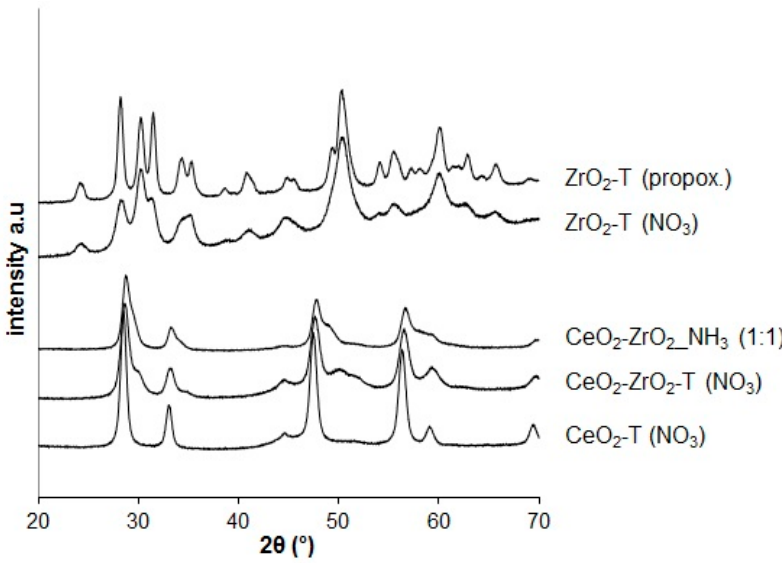
Figure 1. X-ray-diffractograms of ceria, zirconia, and ceria-zirconia mixed oxides prepared by different methods.